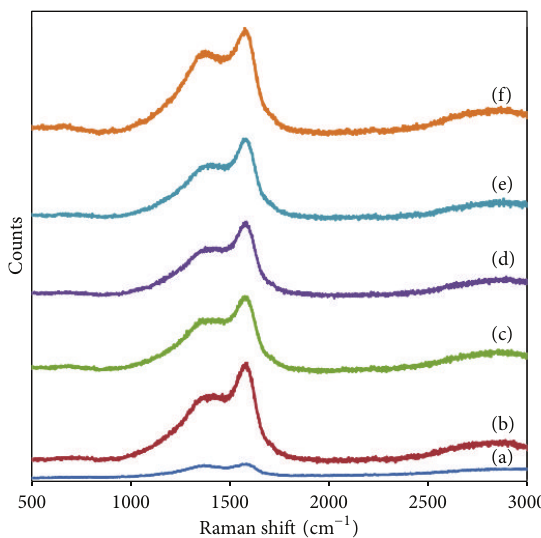
Figure 7: Raman spectra of HCl functionalized 𝛼 CNTH/Ag nanohybrids at different molars of AgNO 3 : (a) 0 M, (b) 0.01M, (c) 0.05 M, (d) 0.1M, (e) 0.5 M, and (f)